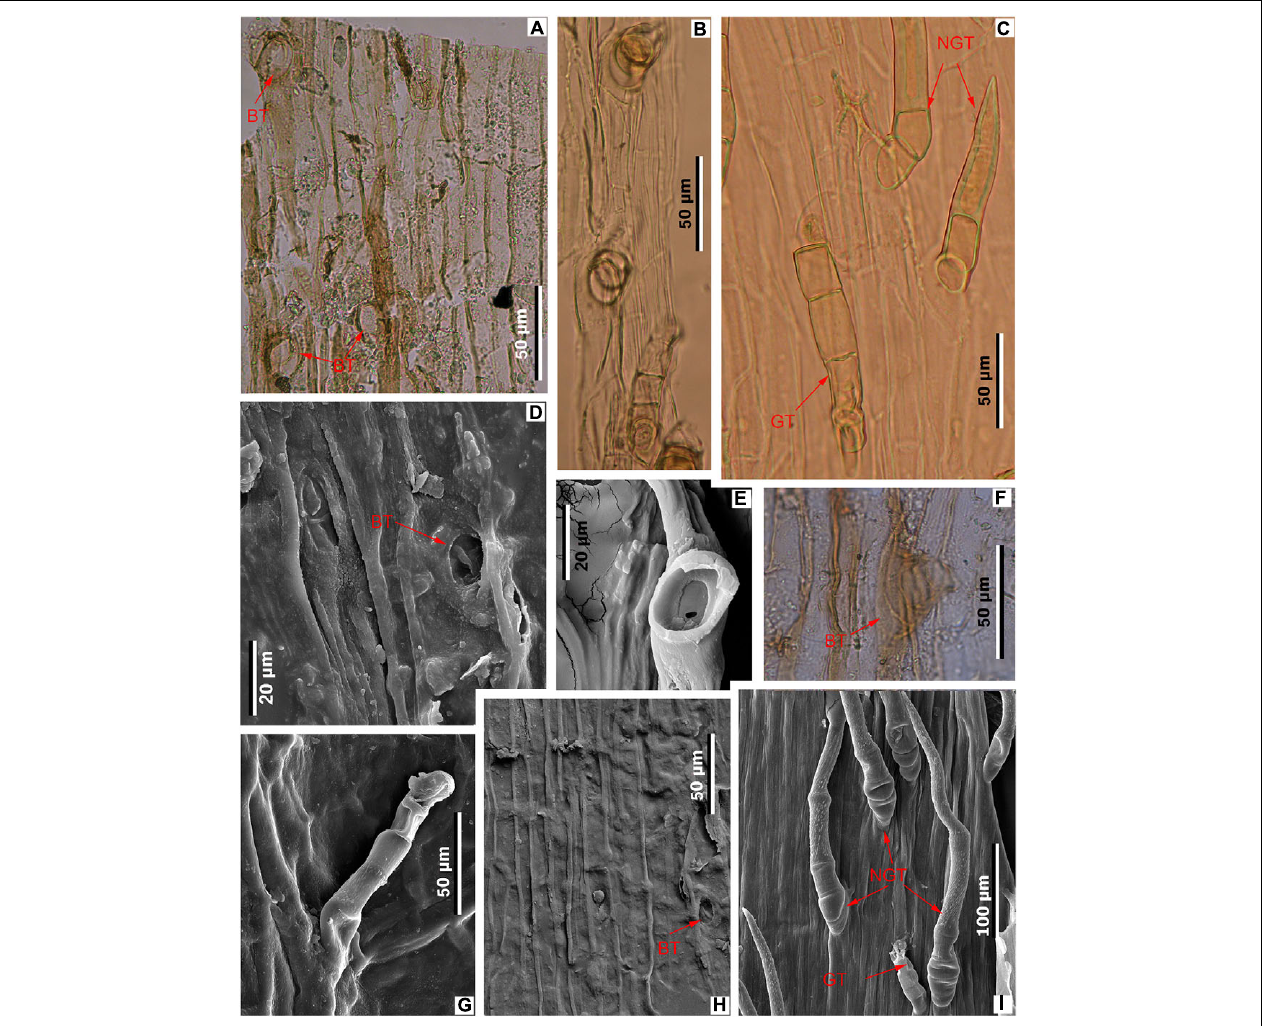
FIGURE 6 | Midvein epidermal characters in fossil and extant Meliosma leaves. M. eosinica sp. nov., holotype, MMJ3-008-1a (A,D,F,H) . (A) Trichome bases (BT), light microscopy (LM). (D) Trichome base, SEM. (F) Glandular(?) trichome base, LM. (H) Ordinary cells of the costal area and trichome base, internal view, SEM. M. rigida Siebold et Zucc., SYS00085214 (B,E) . (B) Trichomes, LM. (E) Base of trichome, external view, SEM. M. simplicifolia (Roxb.) Walp., Xishuangbanna Tropical Botanical Garden (XTBG) (C,G,I) . (C) Glandular (GT) and non-glandular (NGT) trichomes, LM. (G) Glandular trichome (GT), external view, SEM. (I) Glandular (GT) and non-glandular trichomes (NGT), external view,